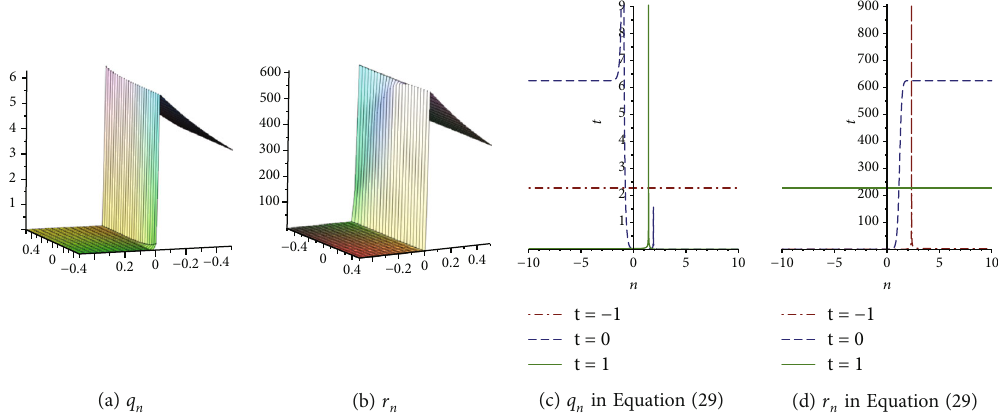
Figure 2: Three-dimensional structure fi gures of explicit solutions from Equation (32) and the evolutions of these solutions with parameters = 0 : 4 , λ = 25 , κ = 32 , and κ = 0 : 8 . λ 1 2 1 2